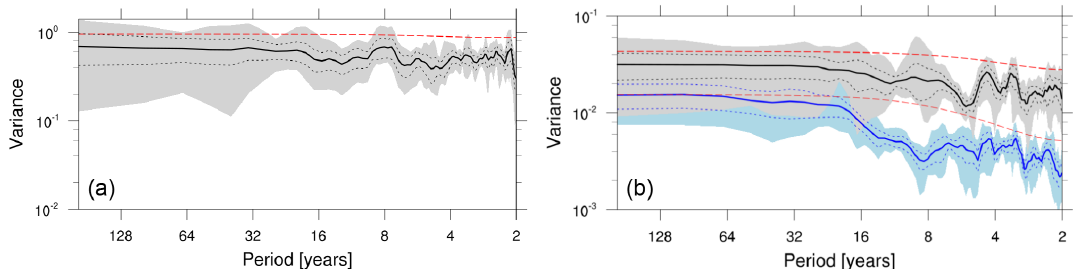
Figure 8. Power spectrum of sea level at Cuxhaven: annual maximum sea level (a) and annual median sea level (b) split into winter (black) and summer season (blue). Spectra have been smoothed over 7 spectral estimates using a Daniell window (Daniell, 1946). The thick lines correspond to an average over nine overlapping 200-year subsets of the full time series, the shadings mark their range. Red lines indicate the 95% confidence bounds using a theoretical Markov spectrum (red noise) and dashed black lines the 95% confidence bounds derived from the nine